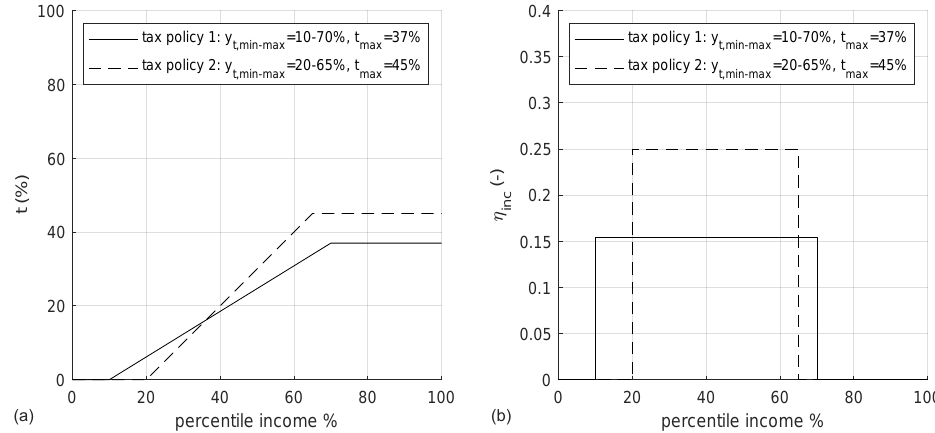
Figure 2. From left to right: ( a ) Tax rate for two tax policies. ( b ) Efficiency coefficient for two tax policies with ξ =